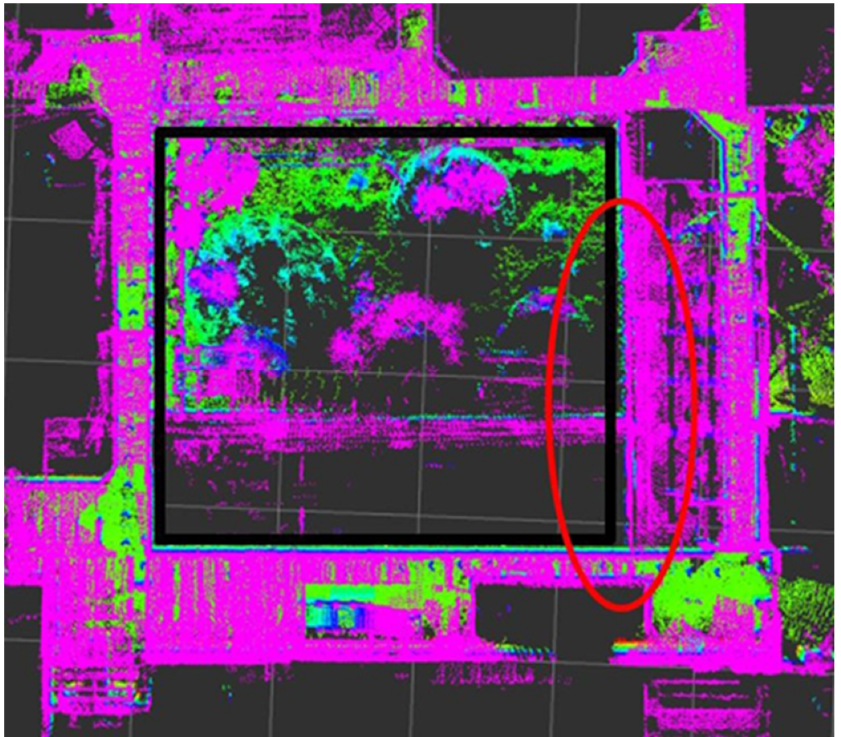
Figure 10. Map of the corridor in the B-building of the University of Applied Sciences Offenburg created with hdl_graph_slam (FAST_GICP).